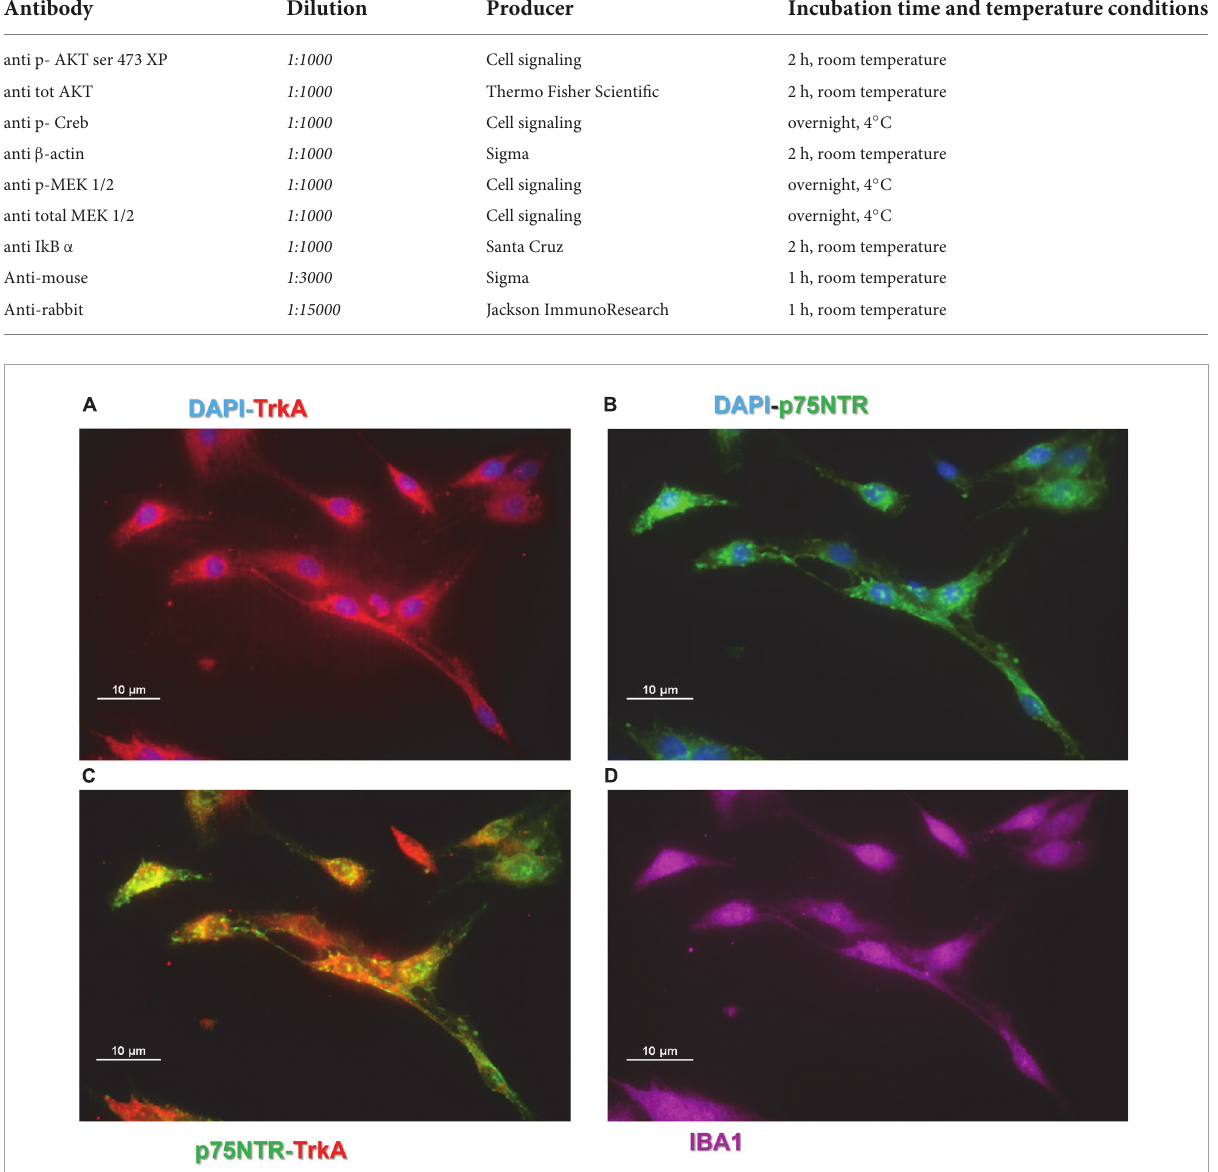
FIGURE1 Expression of nerve growth factor (NGF) receptors in CHME-5 cell lines. (A) Tropomyosin receptor kinase A (TrkA) positive cells. (B) p75 neurotrophin receptor (P75NTR) positive cells. (C) Co-localization of P75NTR and TrkA on CHME-5. (D) IBA positive cells. Magnitude 60X; scale bar 10 µ